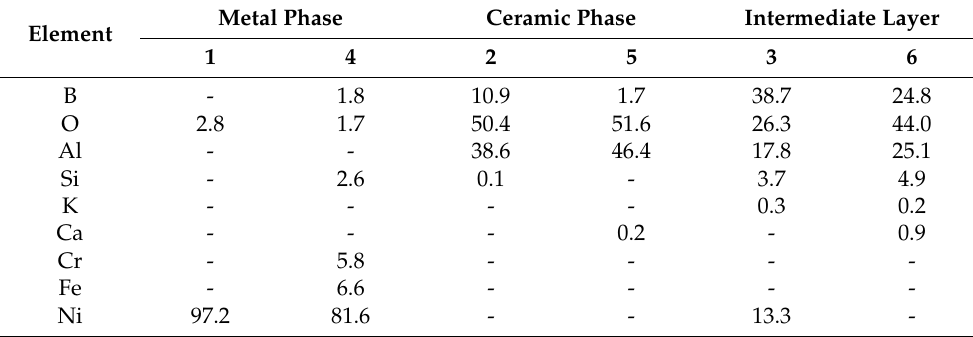
Table 2. Elemental composition of the metal deposits, ceramic substrate and interface areas marked in Figure 4 (in wt.%, by EDS). Metal Element